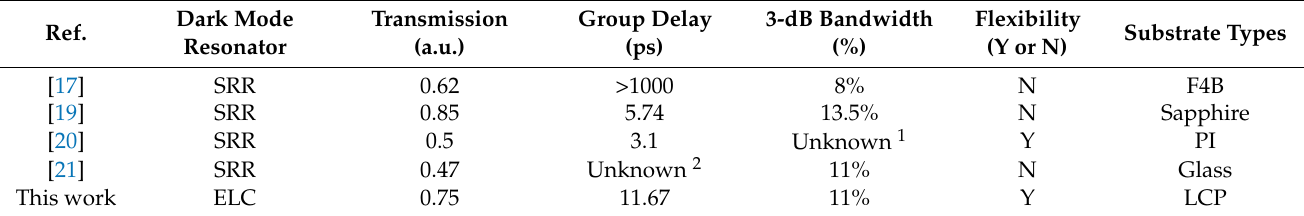
Table 1. Comparison with the experimental results of EIT MTMs already